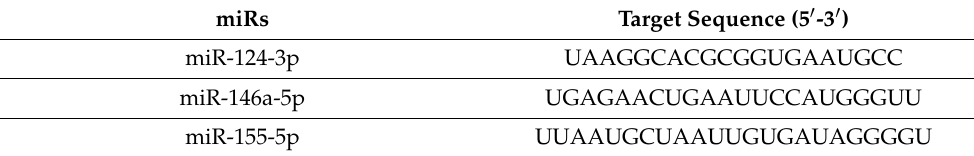
Table 2. List of target sequences used to determine miRNA expression in